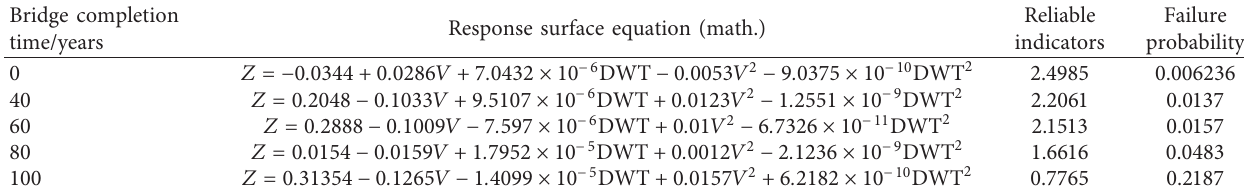
Table 10: Iterative process of ship crash reliability at bridge